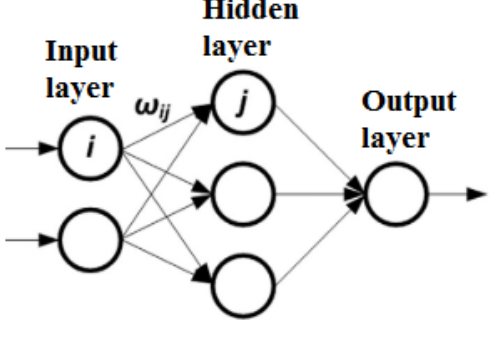
Figure 5. Layers of ANN